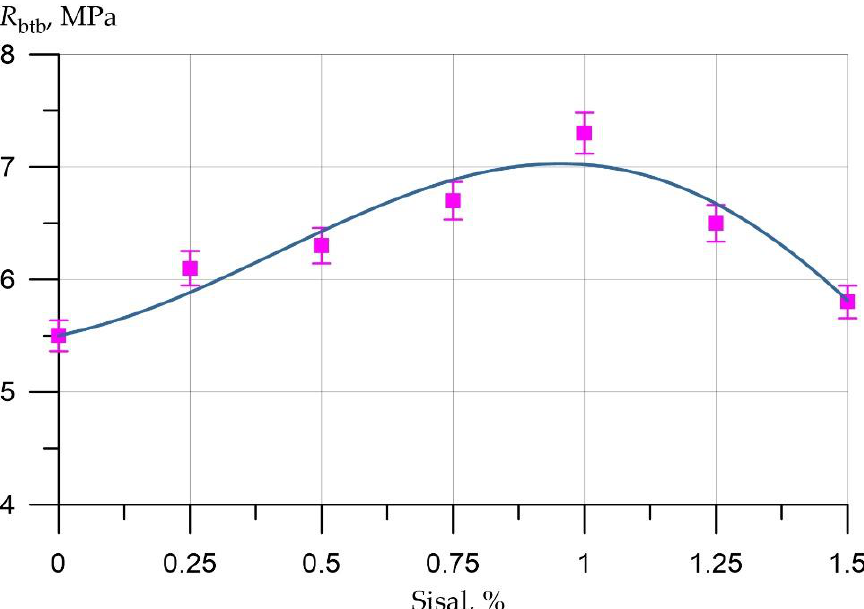
R of concrete samples in btb